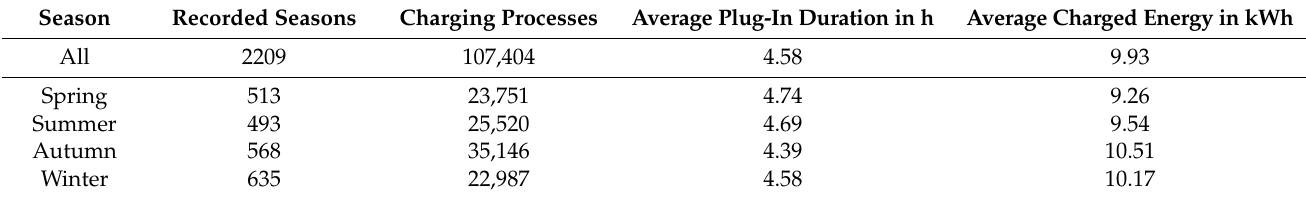
Table 4. Characteristics of the processed data classified by season.